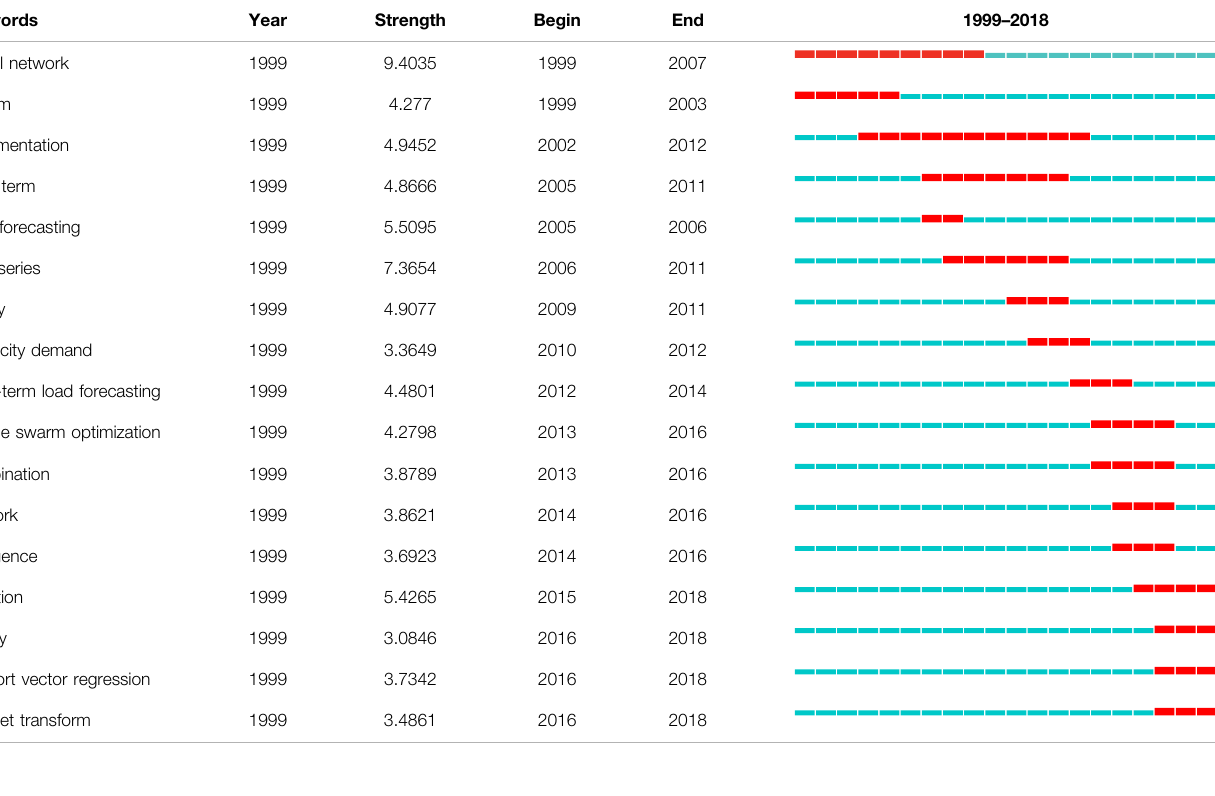
TABLE 6 | Top 17 keywords with bursts during 1999 – 2018.